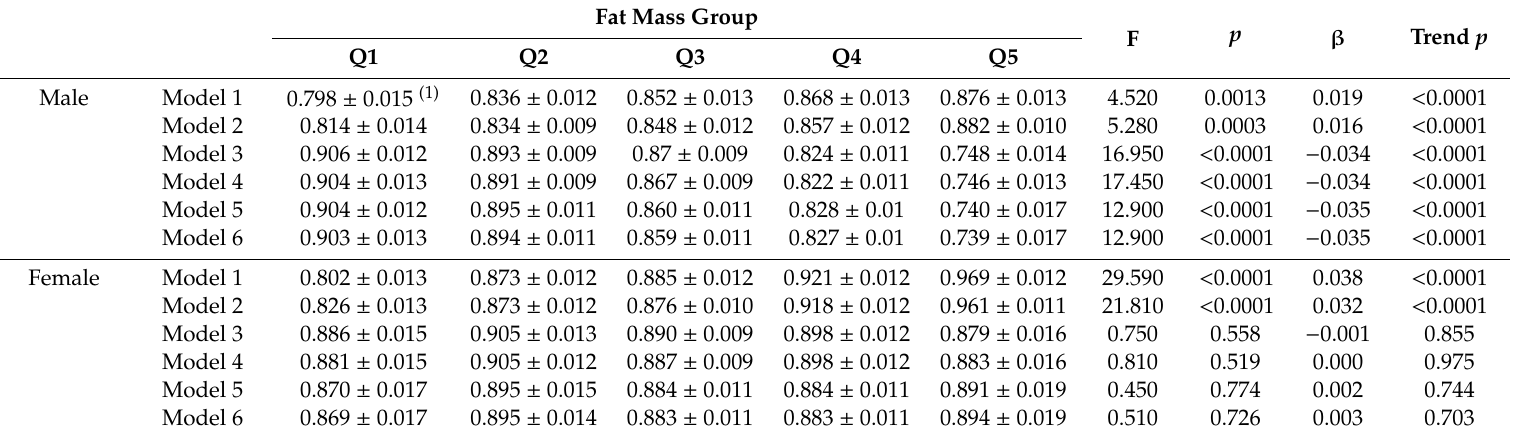
Table 3. Analysis of the bone density (total lumbar spine) di ff erences of fat mass